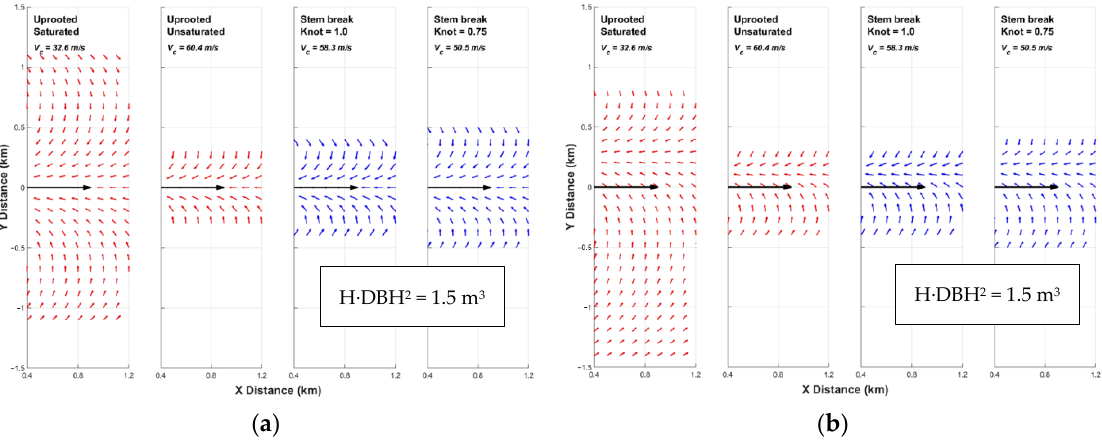
Figure 10. Treefall patterns with a translating vortex with V max = 91 m/s, G max = 6, R max = 240 m and φ = 0.7, ( a ) α = 0° and H·DBH 2 = 1.5 m 3 and ( b ) α = 30° and H·DBH 2 = 1.5 m 3 .